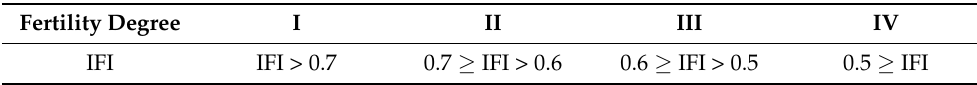
Table 2. The classification criterion of soil integrated fertility index (IFI).